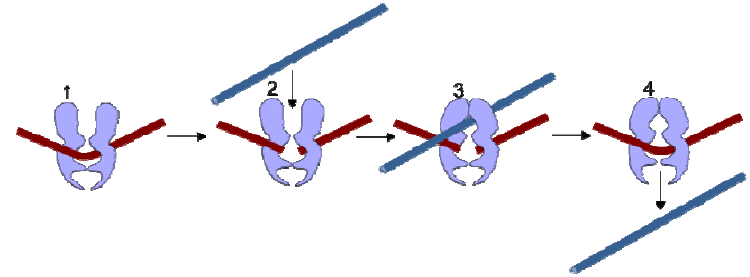
Figure 1. TOP2 mechanism. TOP2 cleaves both strands of a duplex DNA segment (brown, 1–2). A second DNA duplex (blue) passes through the transient enzyme-coupled break